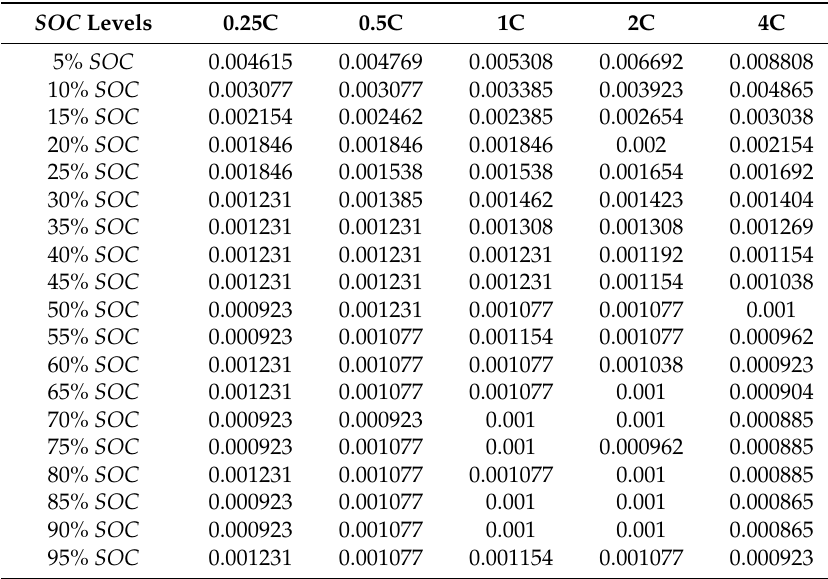
Figure 4. Voltage variations for a discharging pulse and voltage ten seconds after a current pulse. Table 4. 2-D lookup table for the determination of R 1 .